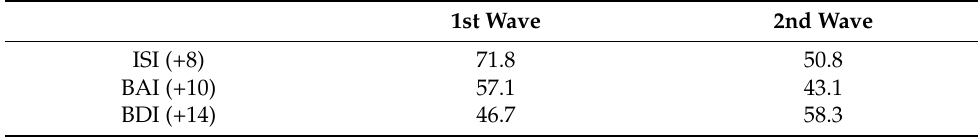
Table 1. Summary of scale scores between